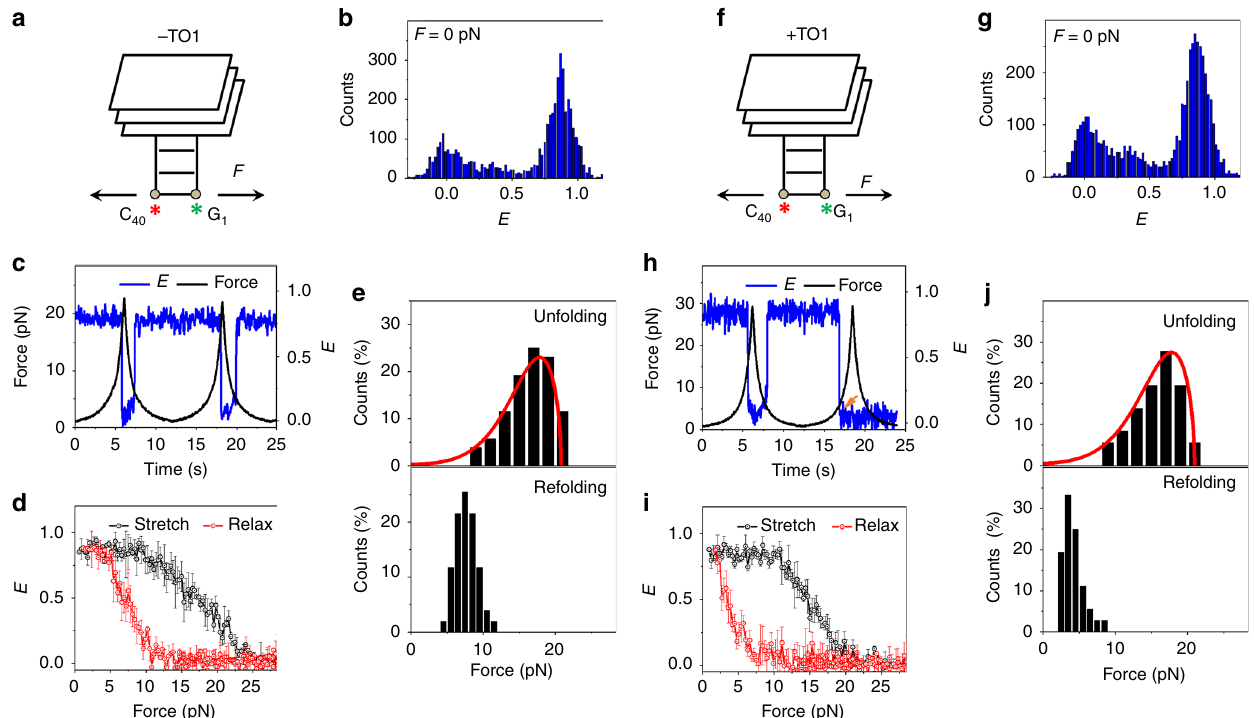
Fig. 4 Conformational dynamics of MangoIV. a A schematic of MangoIV under tension. In view of the proposed structural similarity, the representation is constructed with reference to MangoI crystal structure 9, 18 . The Cy5 and Cy3 dyes adjacent to C 40 and G 1 are shown as red and green asterisks, respectively. To mimic the intracellular ionic conditions, all data shown in this fi gure were collected in a buffer containing 100 mM K + and 1 mM Mg 2 + . b E histograms of MangoIV, in the absence of force. c A representative FRET time trajectory of a single molecule of MangoIV over two pulling cycles. d Average E vs force response. e Distributions of unfolding (top) and refolding forces (bottom). ( N = 51 for both). f A schematic of TO1-MangoIV module under tension. Force ( F ) applied on the construct is shown by arrows. g E histogram of MangoIV in a buffer containing saturated concentrations of TO1, in the absence of force. h A representative smFRET time trajectory of MangoIV in the presence of TO1. The orange arrow indicates photobleaching of the dyes. i Average E vs force response in TO1 containing buffer. j Distributions of unfolding and refolding forces. ( N = 36 for both). The time trajectories were acquired at an integration time of 20 ms. The red curves in e and j represent force distributions estimated from the Dudko – Szabo models 46, 47 . All error bars represent standard